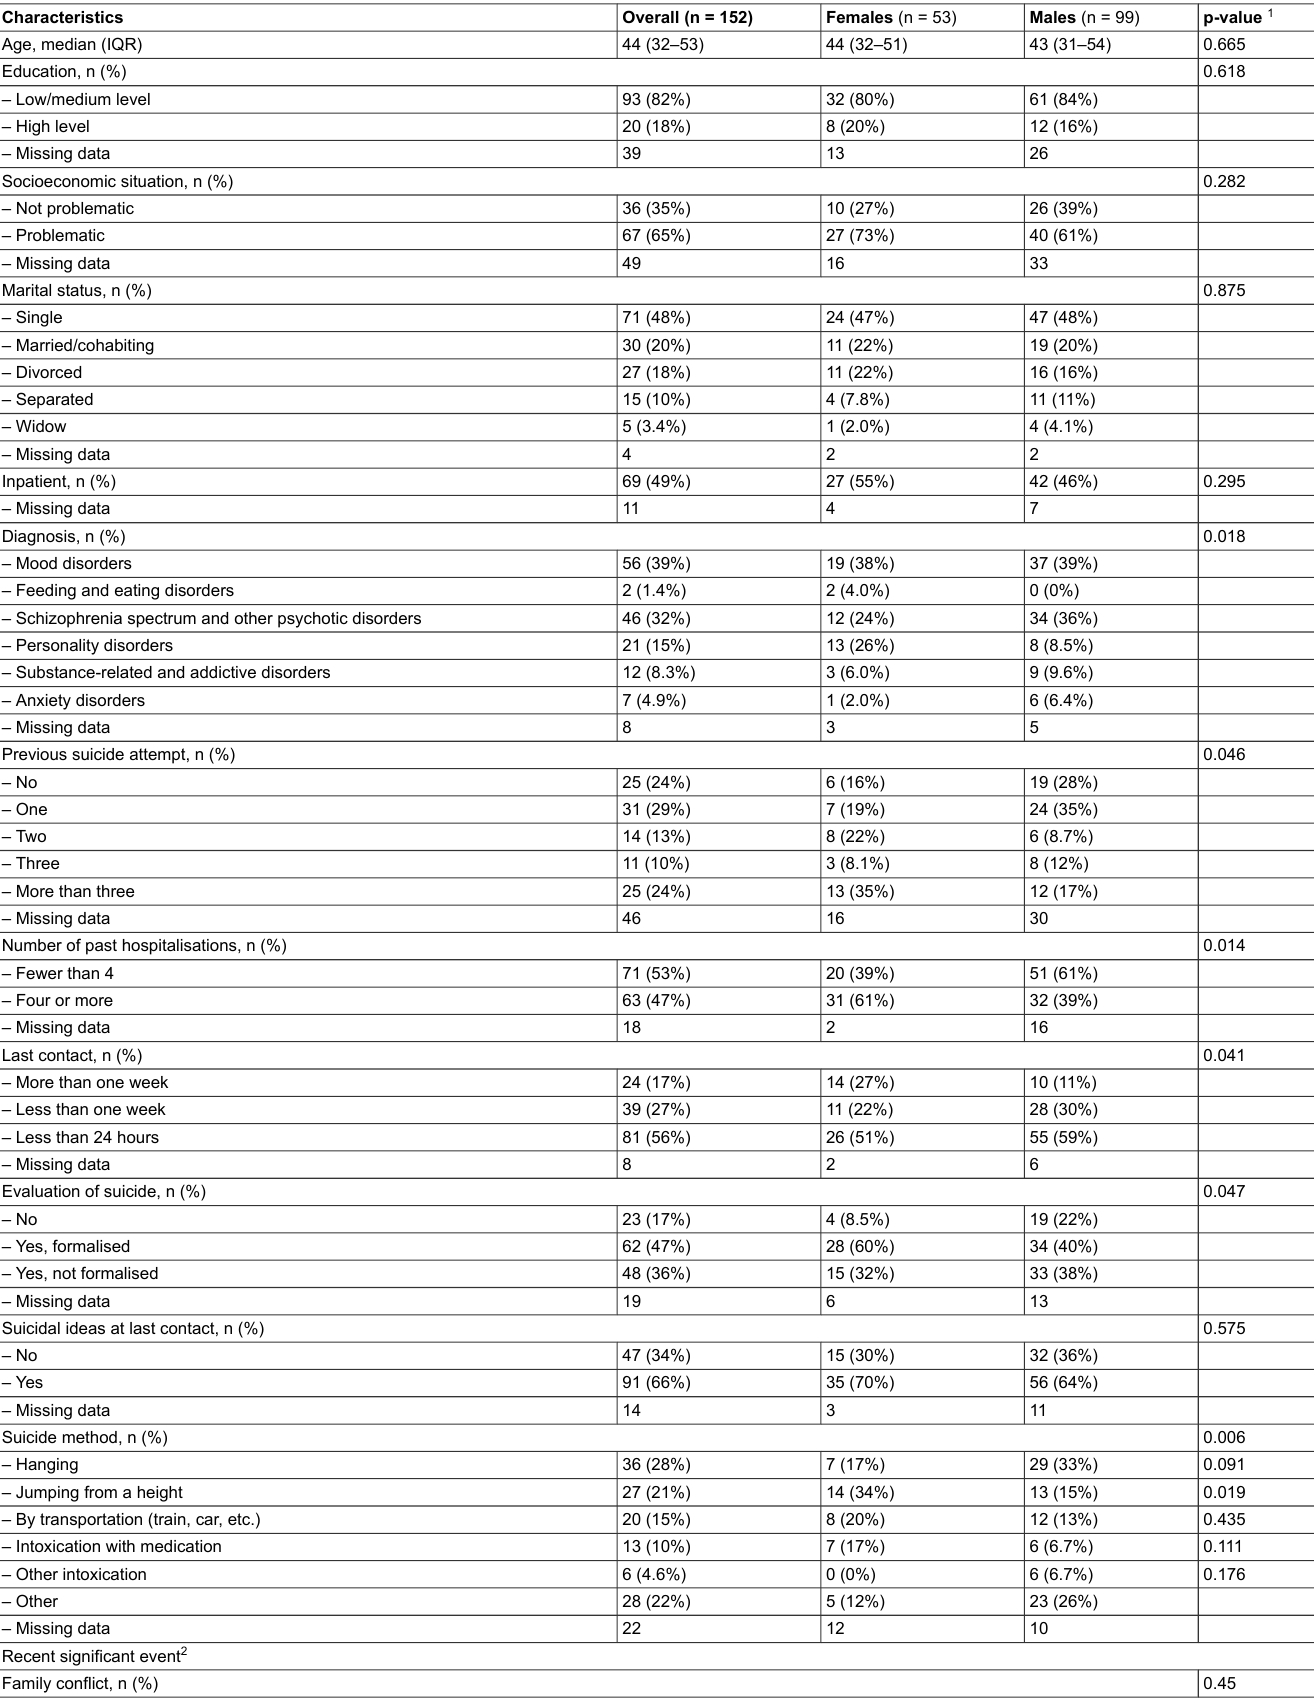
Table 4: Comparison between